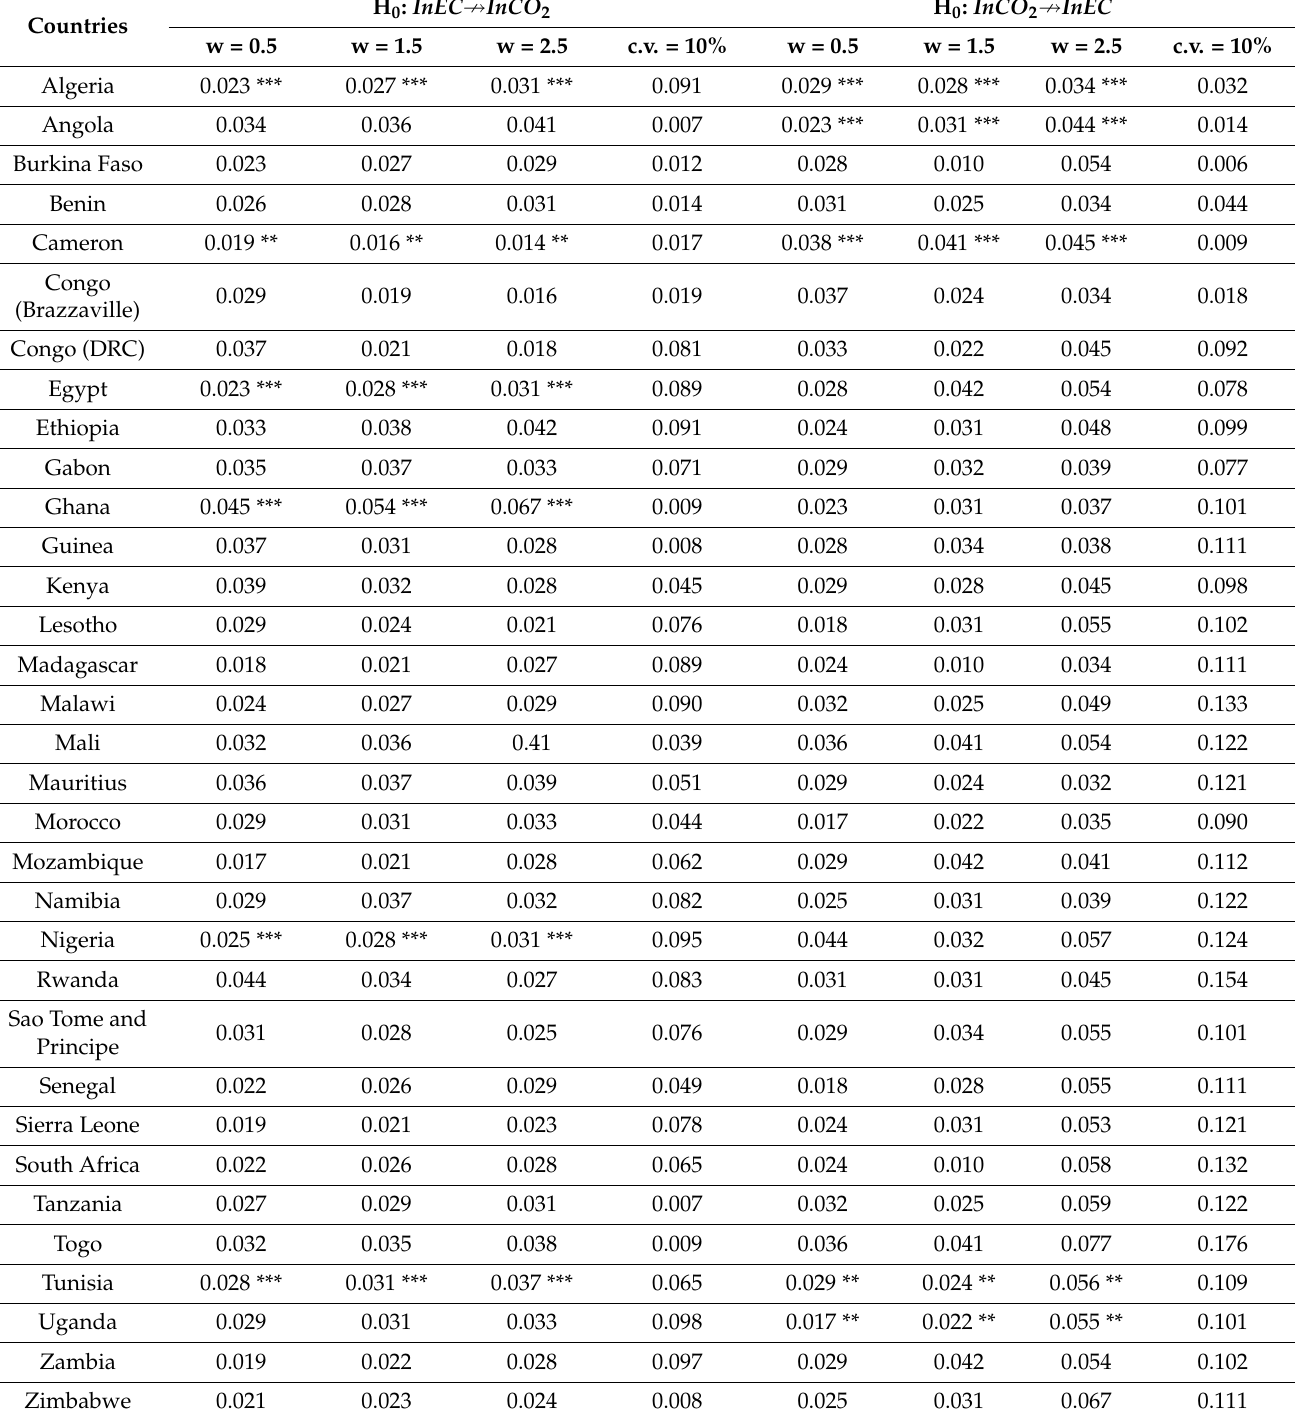
Table 6. Granger causality tests in the frequency domain estimates InEC , InCO 2